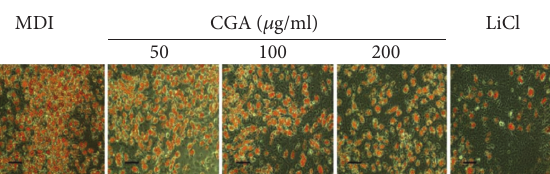
Figure 3: Representative ORO staining of different groups in 3T3-L1cells induced for 7 days. Scale bar: 200 μ m.